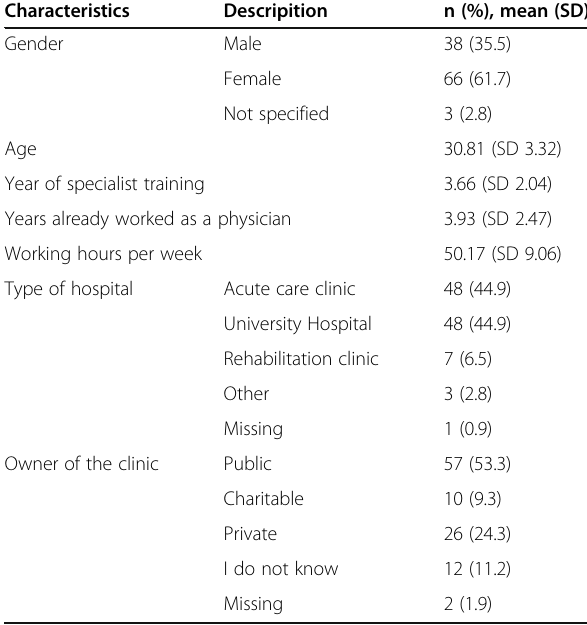
Table 1 Socio-demographic data